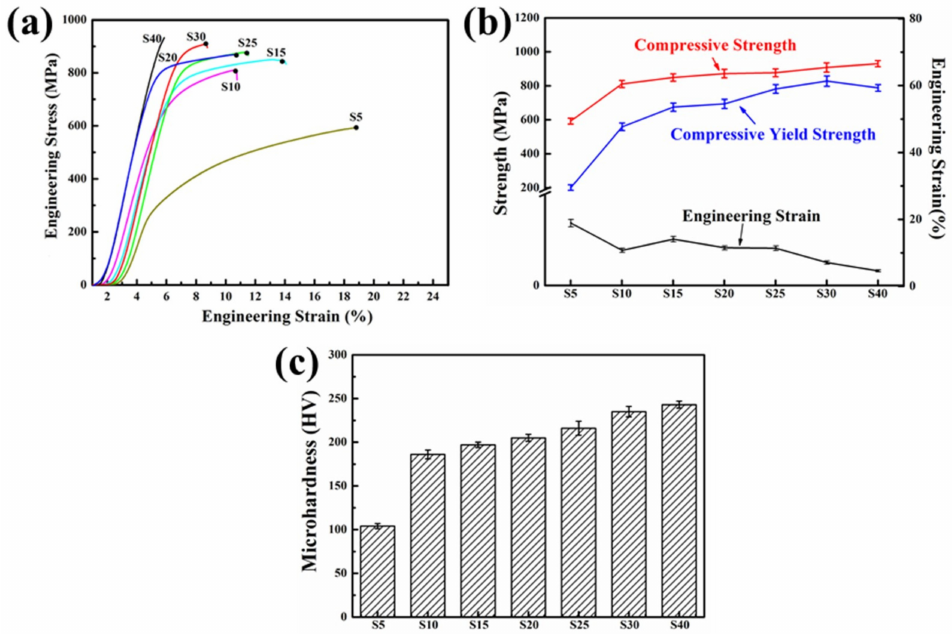
Figure 11. Sintered samples for di ff erent ball milling time ( a ) compressive stress-strain curves, ( b ) values of strength and strain and ( c ) Vickers